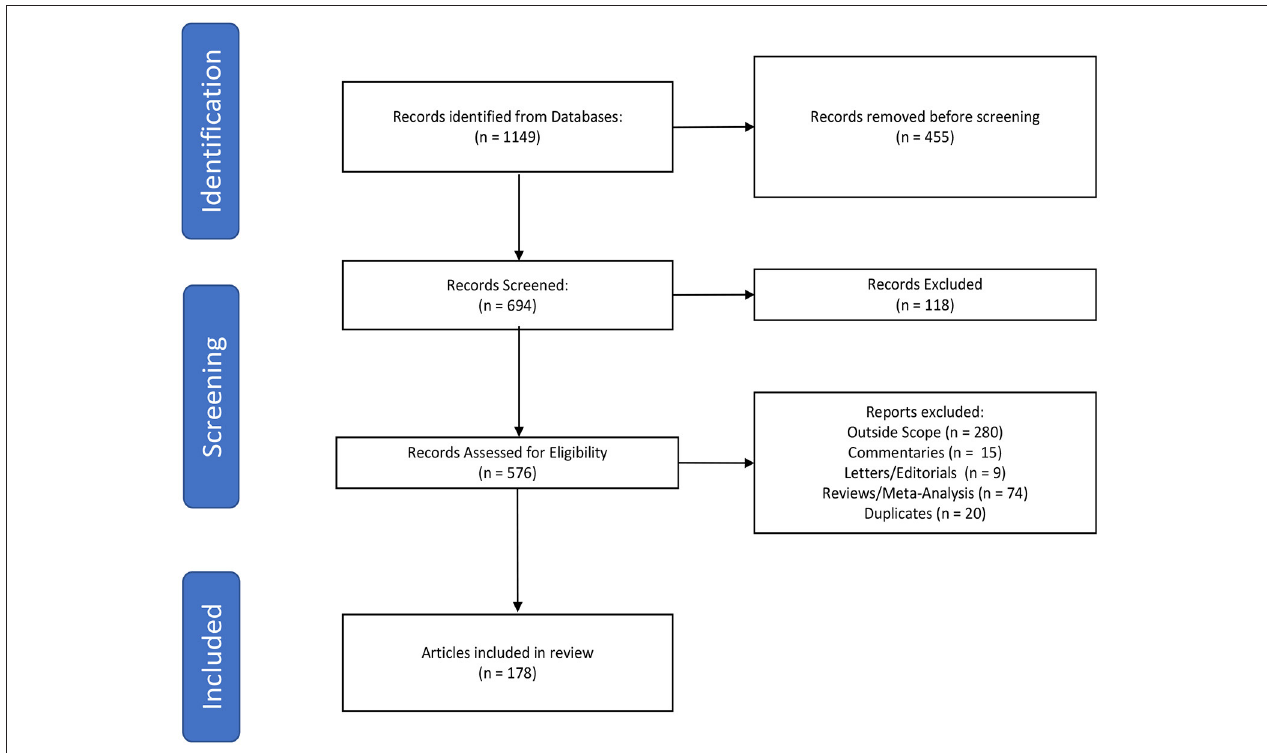
FIGURE 1 | Flowchart demonstrating identification, screening, and inclusion of articles.